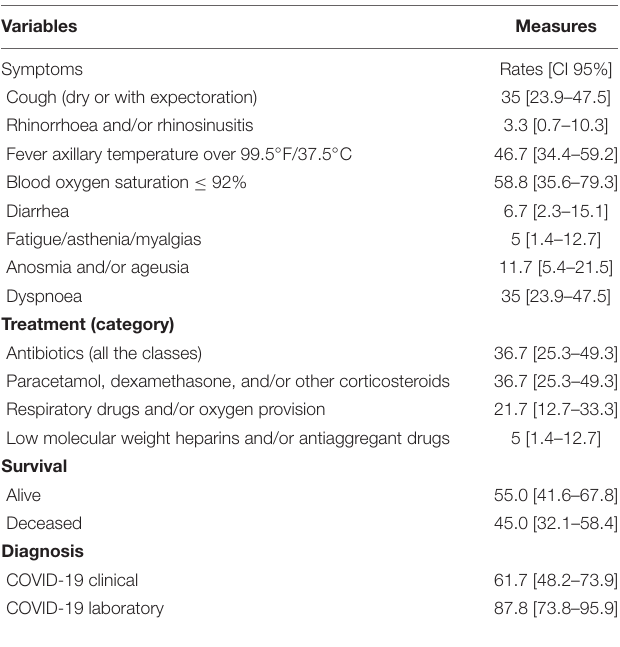
TABLE 3 | Patients clinical outcomes at follow-up (February 1st–December 31st,